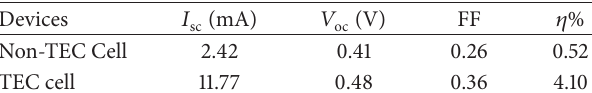
Table 1: Parameters of current-voltage characteristics of NPS/poly- Si cells with and without TECstructures. The devices were measured by a solar simulator under irradiation of 𝑃 𝐿 = 100 mW/cm 2 at AM1.5, with an irradiated area of 0.5 cm 2 .